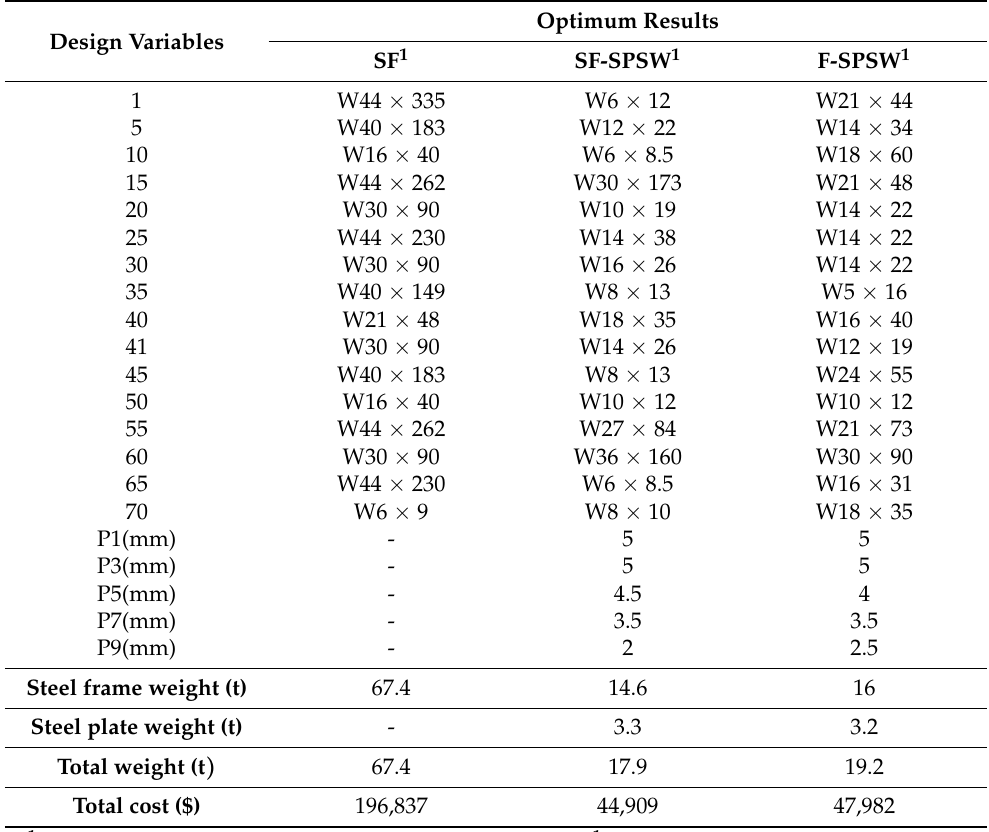
Table 5. Results of SF 1 and SF-SPSW 1